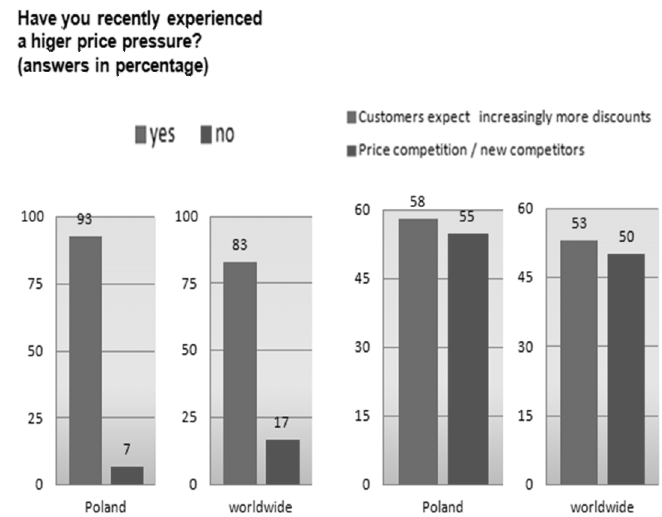
Figure 2. Price competition in Poland and worldwide (Polish companies are more susceptible to price pressure) Source: Simon-Kucher & Partners, after